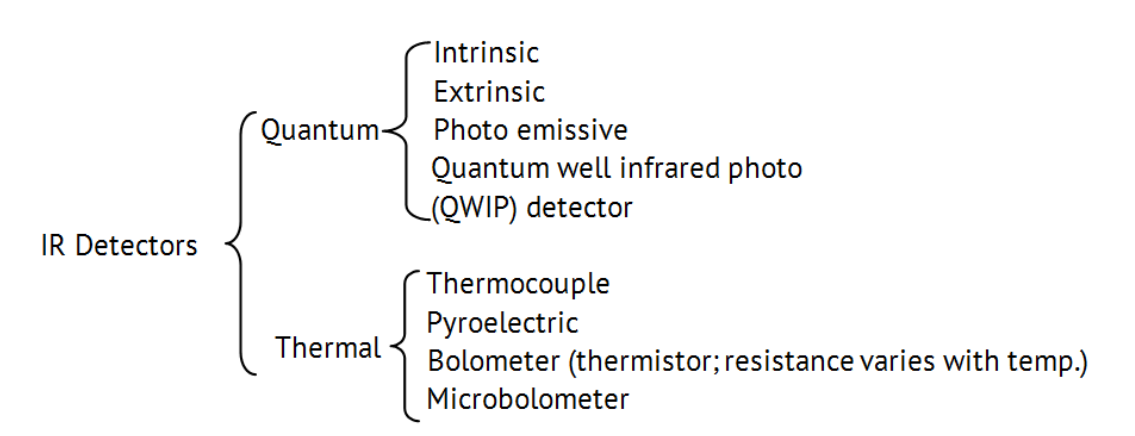
Figure 3. Classification of detectors.